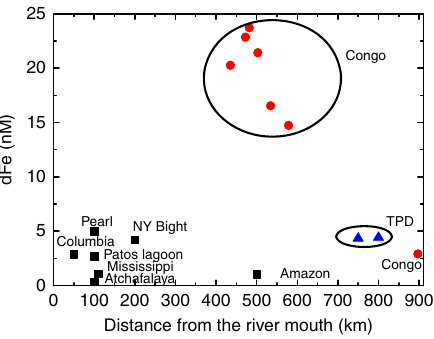
Fig. 3 Comparison of dFe concentrations vs. distance from the river mouth in other riverine systems globally. The presence of dFe several hundreds of kilometer off-shelf indicates more rapid horizontal mixing of Congo River plume compared with other systems 1,5,27,54,67 – 69 . TPD indicates transpolar drift, and NY Bight indicates New York Bight. Source data are provided as a Source Data fi